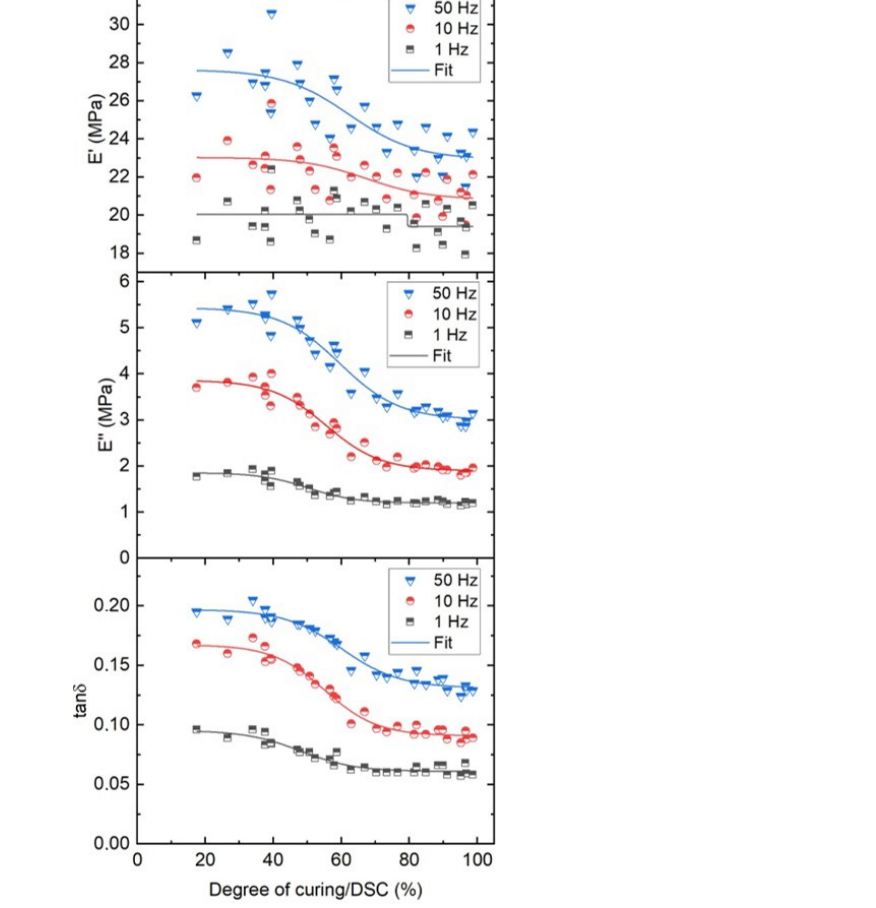
Figure 14. Storage modulus (top), Loss modulus (mid) and Damping factor (bottom) calculated from tensile-DMA of the EVA bulk as a function of 30 different DoCs. Table 3. Extracted coefficient of determination R 2 for the fit functions shown in Figure